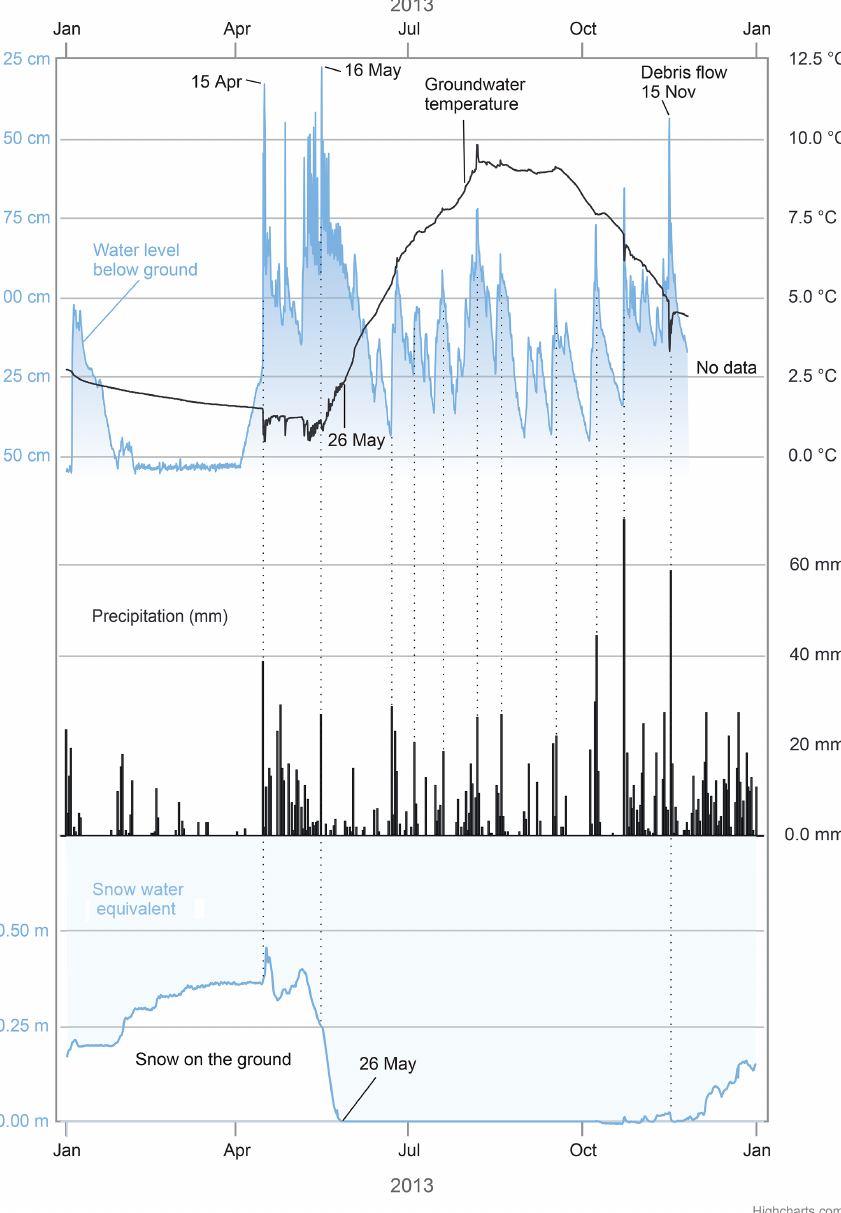
Figure 6. The upper diagram shows groundwater level (blue curve) and groundwater temperature (black curve) from the borehole on the slope in 2013. The middle diagram shows 24h precipitation at the weather station at Selseng (Fig. 4a) (station no. 55700, http://eklima.met.no, last access: 4 February 2019). The lower diagram shows the snow water equivalent measured with a snow pillow at the weather station 77.24.0 (Fig. 4b). The small wiggles in the temperature curve end on 26 May – the same day the snow pillow was free of snow. One of the most pronounced oscillations is on 15–16 November, when a debris flow occurred on this